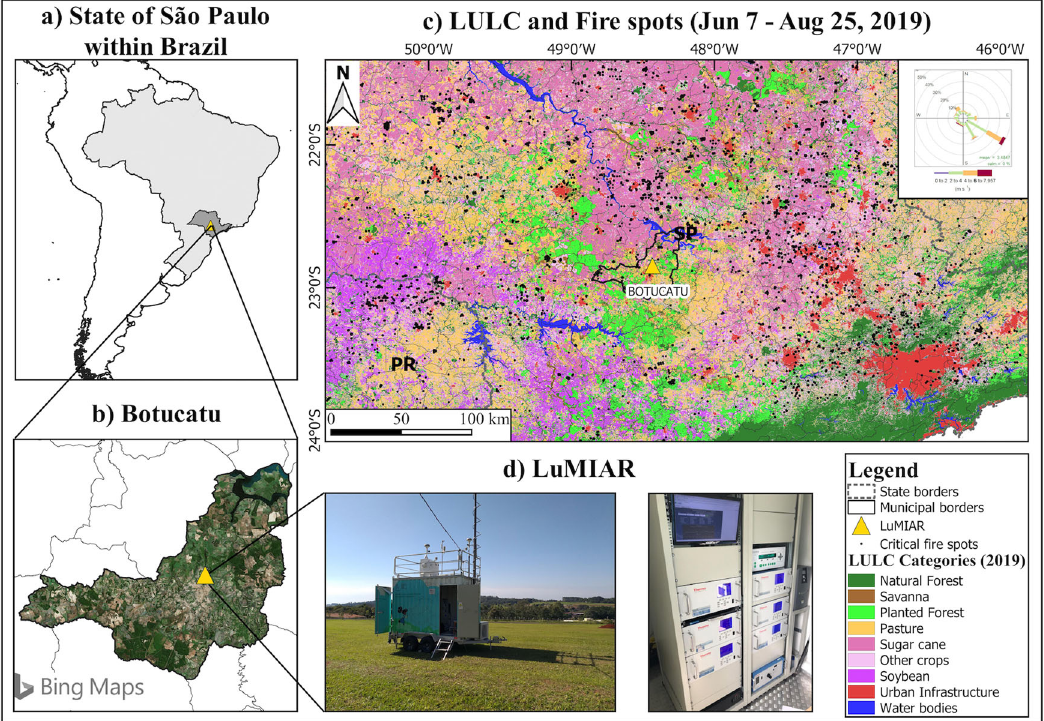
Fig. 1 Location and characterization of the study area. a , b Maps showing the location of the sampling site (within the city of Botucatu, Brazil). c Land use and land cover (LULC) for the study area and its surroundings in 2019. PR: (state of) Paraná; SP: (state of) São Paulo. d External and internal view of the laboratório móvel para pesquisa e monitoramento da qualidade do ar (LuMIAR, mobile laboratory for air quality monitoring and research) used in this study. Source: The LULC map was obtained after the reclassi fi cation of MapBiomas data (Project MapBiomas — Collection 5 of Brazilian Land Cover and Use Map Series, accessed on December 2, 2020, through the link: https://mapbiomas. org/colecoes-mapbiomas-1?cama_set_language = pt-BR) 56 , a public mapping of Brazil, based on Landsat images with a spatial resolution of 30 m. Fire spots were provided by INPE, Instituto Nacional de Pesquisas Espaciais, 2020, Portal de Monitoramento de Queimadas e Incêndios Florestais. Available at http://www.inpe.br/queimadas. Accessed on December 14,